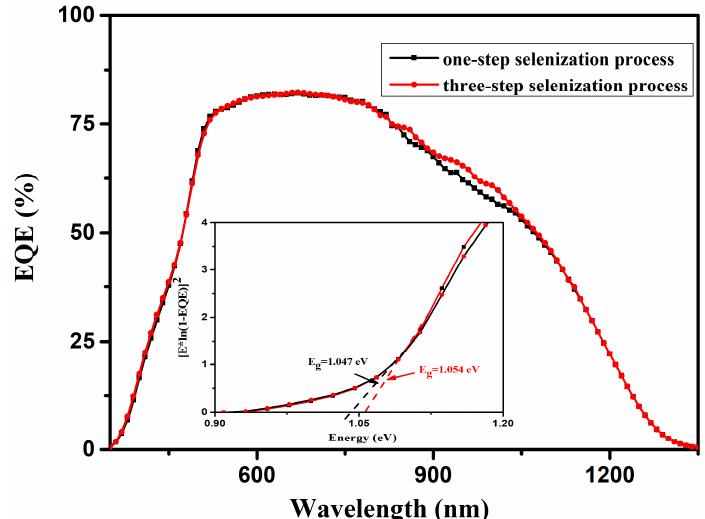
Figure 6. External quantum efficiency of CZTS solar cells fabricated by the one-step and three-step selenization process. Inset: Extrapolation of the band gaps from the external quantum efficiency (EQE) data.